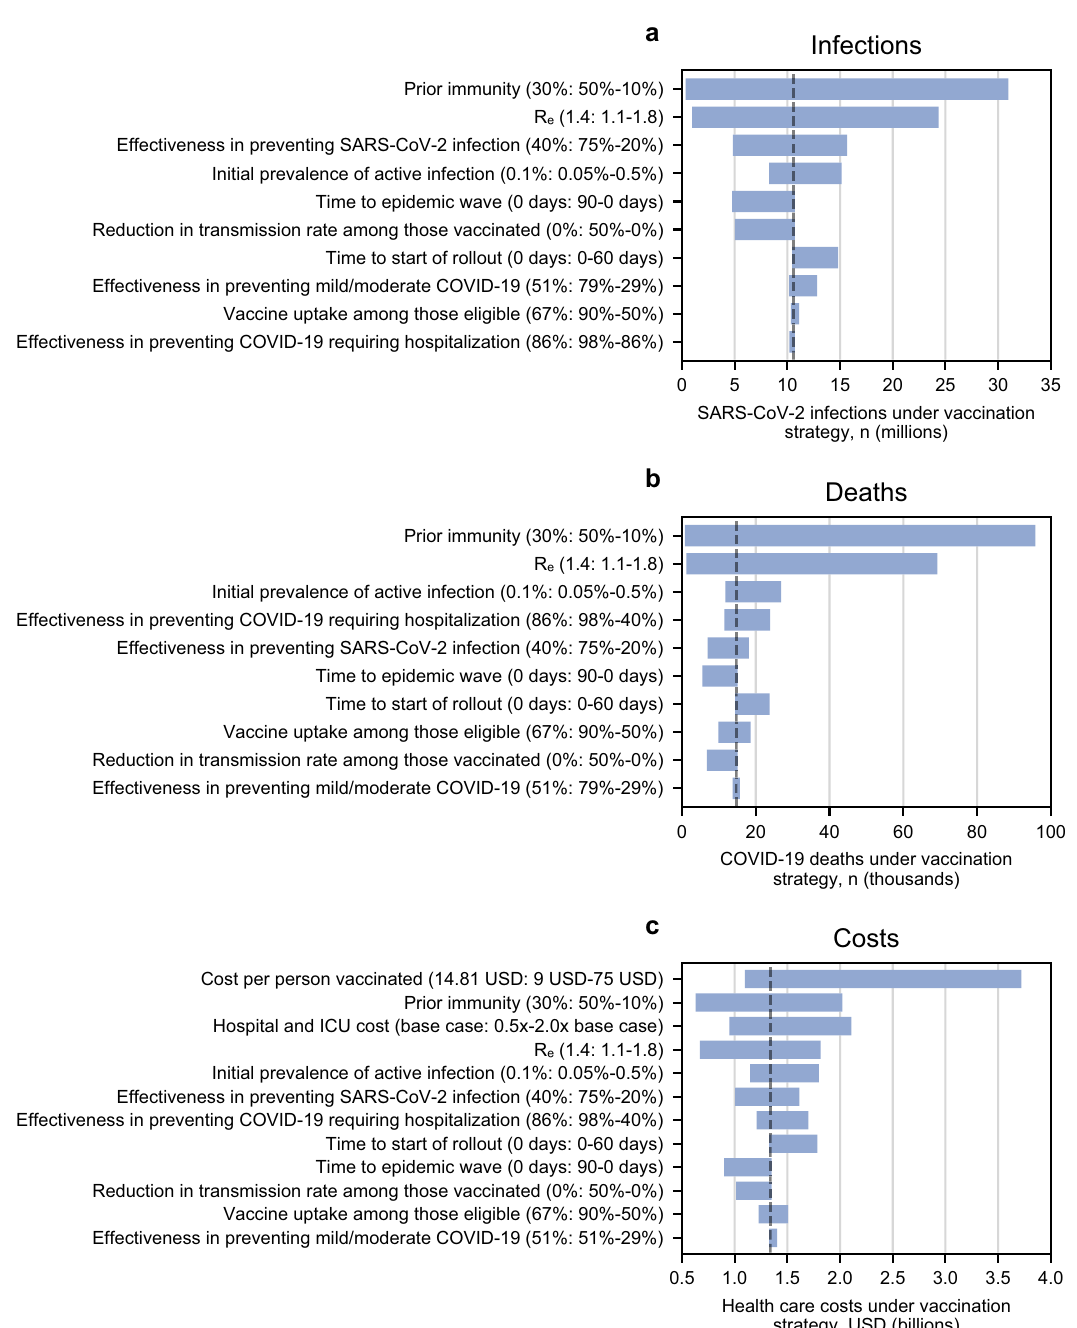
Fig. 1 One-way sensitivity analysis: in fl uence of each parameter on cumulative SARS-CoV-2 infections, COVID-19 deaths, and health care costs. This tornado diagram demonstrates the relative in fl uence of varying each key model parameter on clinical and economic outcomes over 360 days. This is intended to re fl ect the different scenarios in which a reference vaccination program (vaccine supply suf fi cient for 67% of South Africa ’ s population, pace 150,000 vaccinations per day) might be implemented. The dashed line represents the base case scenario for each parameter. Each parameter is listed on the vertical axis and in parentheses are the base case value and, after a colon, the range examined. The number on the left of the range represents the left- most part of the corresponding bar and the number on the right of the range represents the right-most part of the corresponding bar. The horizontal axis shows the following outcomes of a reference vaccination program: a cumulative SARS-CoV-2 infections; b cumulative COVID-19 deaths; c cumulative health care costs. In some analyses, the lowest or highest value of an examined parameter produced a result that fell in the middle of the displayed range of results, due to stochastic variability when the range of results was